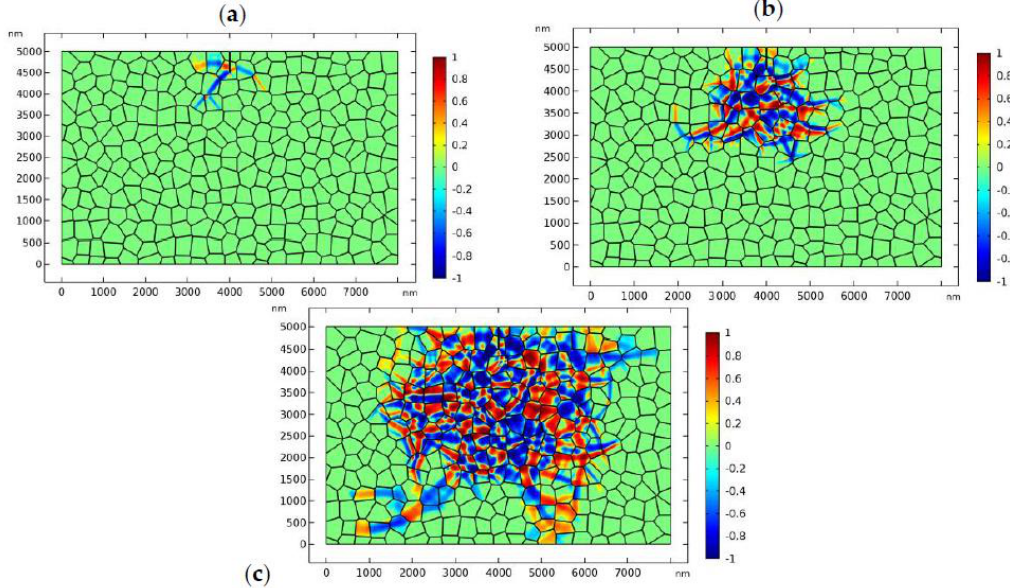
Figure 5. The equilibrium phase patterns around the crack tip under different loads: ( a ) σ a = 60 MPa; ( b ) σ a = 90 MPa; and ( c ) σ a = 120 MPa. The ambient temperature is T = 1360